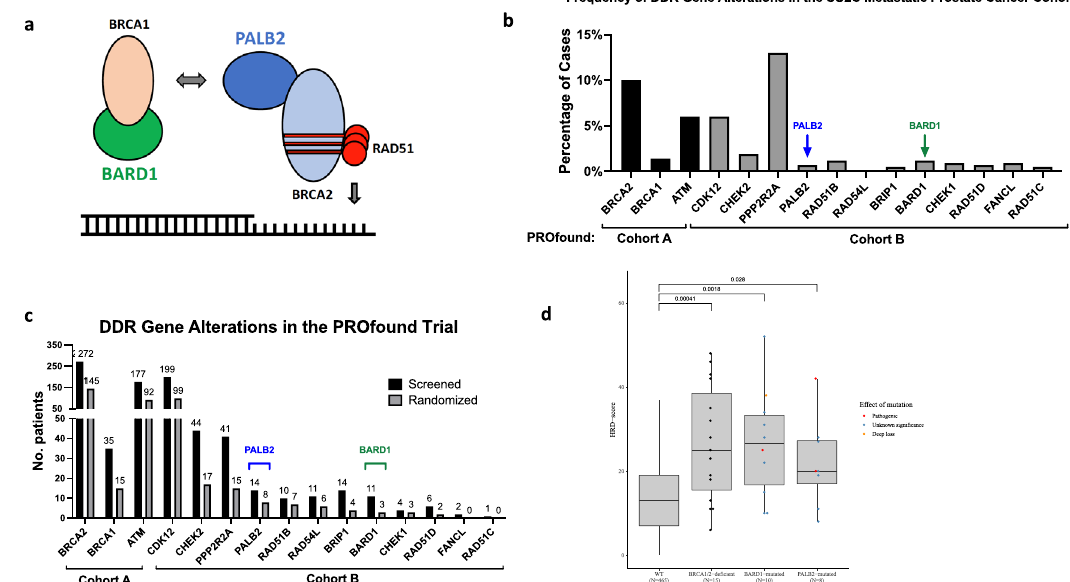
Fig. 1 DDR gene alterations and mutational signatures in prostate cancer. a Model depicting known interactions among BRCA1, BRCA2, PALB2, and BARD1 at sites of DNA double-strand breaks. b Frequency of DDR gene alterations in the SU2C dataset 5 . The genes selected for display are the genes that were included in the PROfound study 10 . c Frequency of qualifying DNA repair gene alterations in screened and randomized patients in the PROfound trial of olaparib in metastatic castrate-resistant prostate cancer 10 . d HRD scores calculated from WES from TCGA prostate cancer (PRAD) cohort. For each boxplot, the center line, box bounds, and whisker bounds represent the median value, ±interquartile range (IQR), and ±1.5 × IQR, respectively. DDR, DNA damage and repair. SU2C Stand Up to Cancer. TCGA The Cancer Genome Atlas. WES whole exome